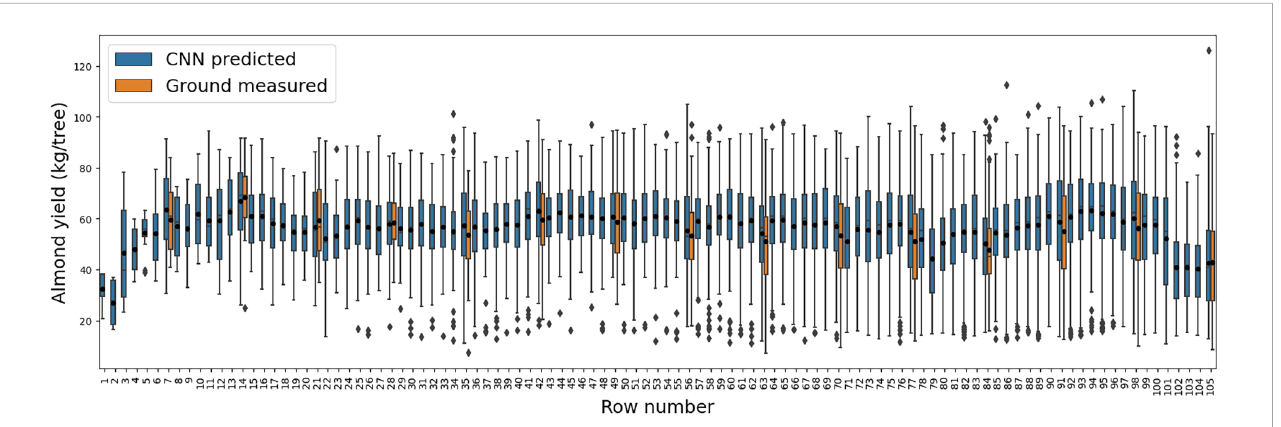
FIGURE 8 Yield variation within each row as represented by the boxplots of the tree-level yield estimated by the CNN model (blue), and across individual rows. The boxplots of measured yield record for those rows with individual tree harvesting are also shown here in orange for comparison.